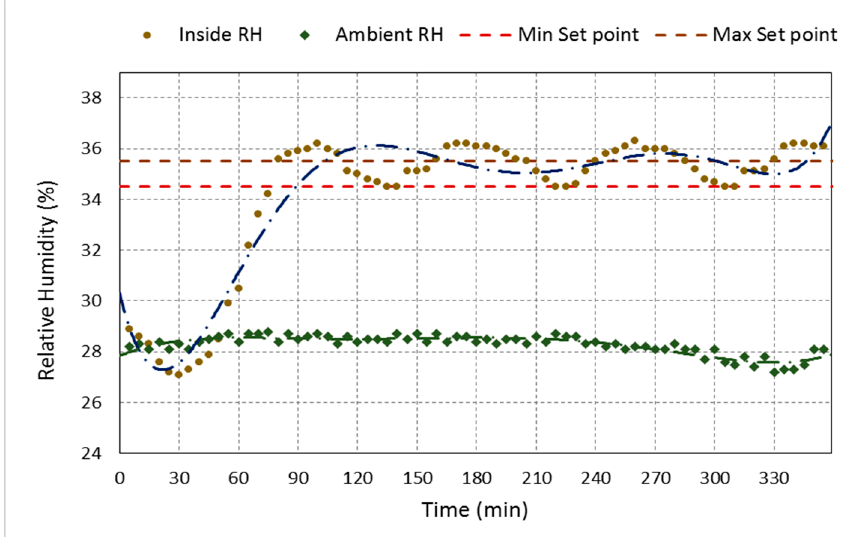
Figure 15. Ambient temperature, inside temperature of the testing chamber, compared to the mini- mum and maximum set points of 29.5 °C and 30.5 °C to obtain the target temperature of 30 °C at 35% relative humidity (RH) for 6 h.